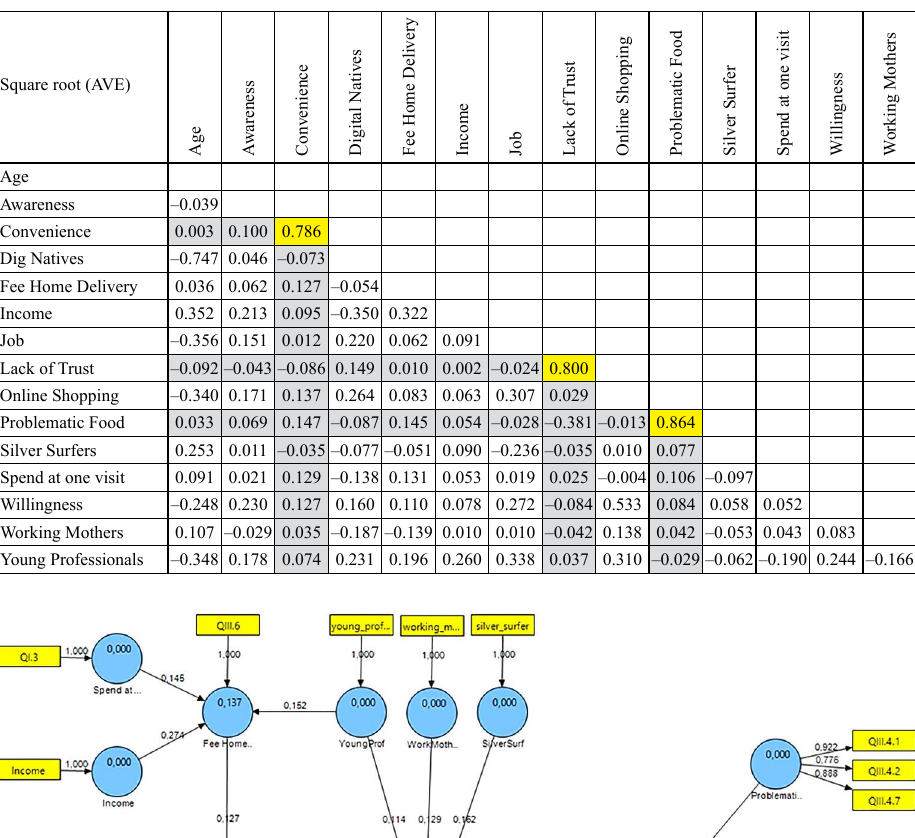
Table 4. Fornell-Larcker criterion-discriminant validity